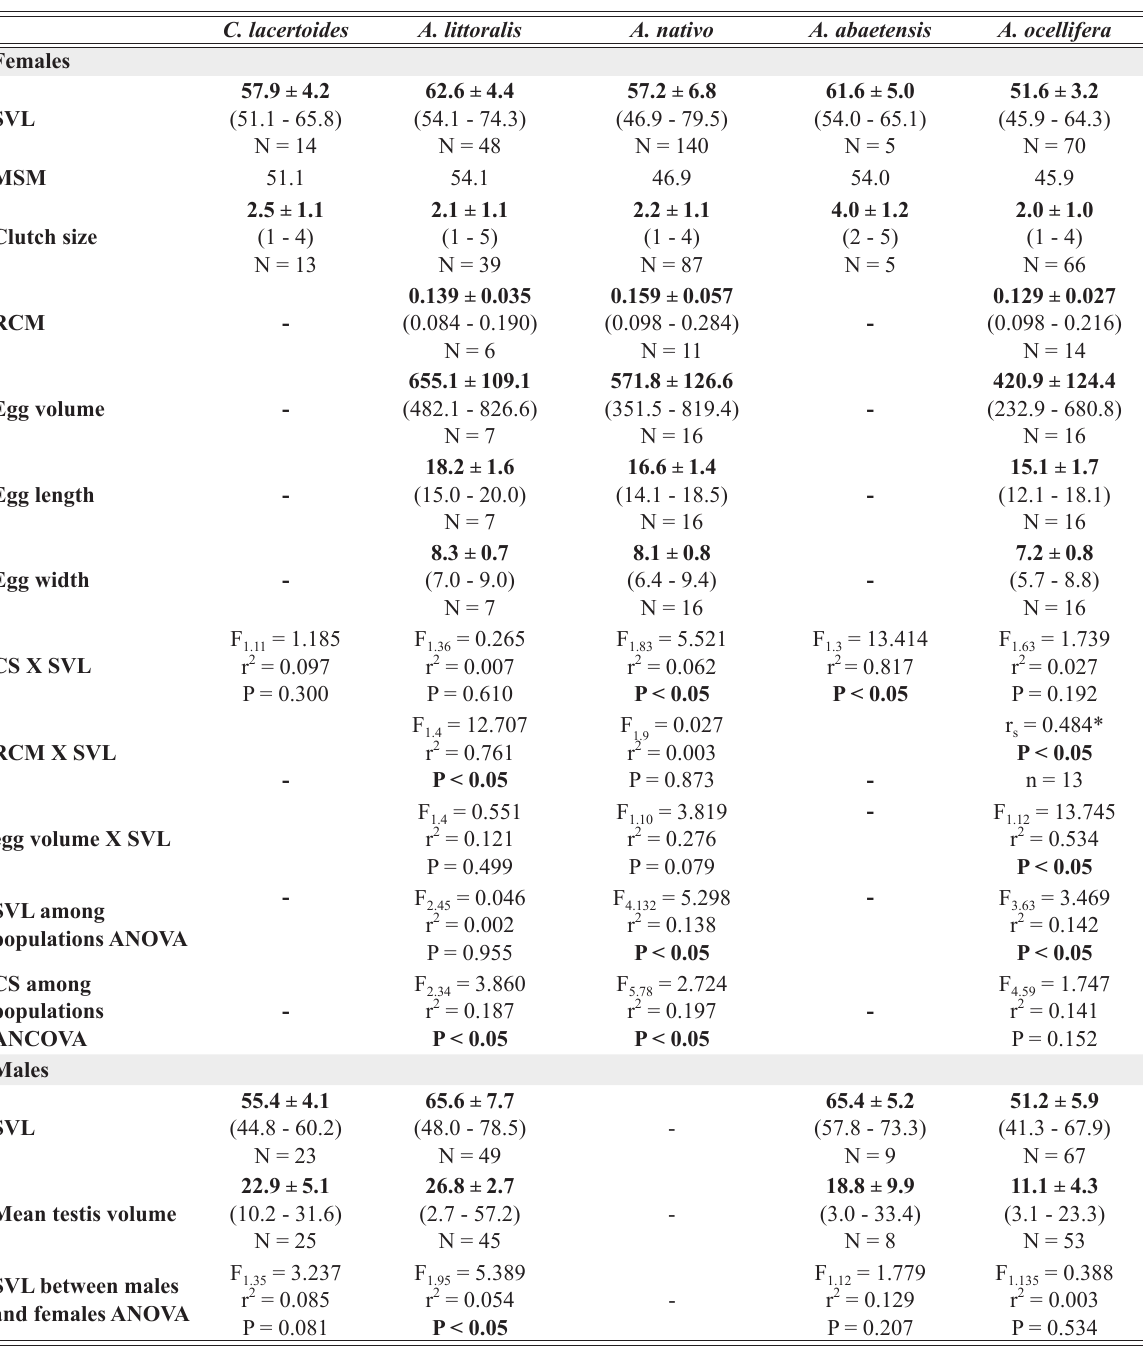
Figure 4 - Mean snout-vent length (SVL, in mm), minimum size at sexual maturity (MSM, in mm), mean clutch size, relative clutch mass (RCM), volume (in mm 3 ), length and width (in mm) of eggs, and testis volume (in mm 3 ) for five cnemidophorines species studied along the eastern Brazilian coast. Values are represented by arithmetic mean + one standard deviation with the range in parentheses and sample size below. Simple regression analyses between clutch size (CS), RCM and egg volume and female SVL. Results of Analyses of Variance for differences in SVL between males and females. Analysis of Variance (ANOVA) of female SVL and Analysis of Covariance (ANCOVA) of CS among populations of